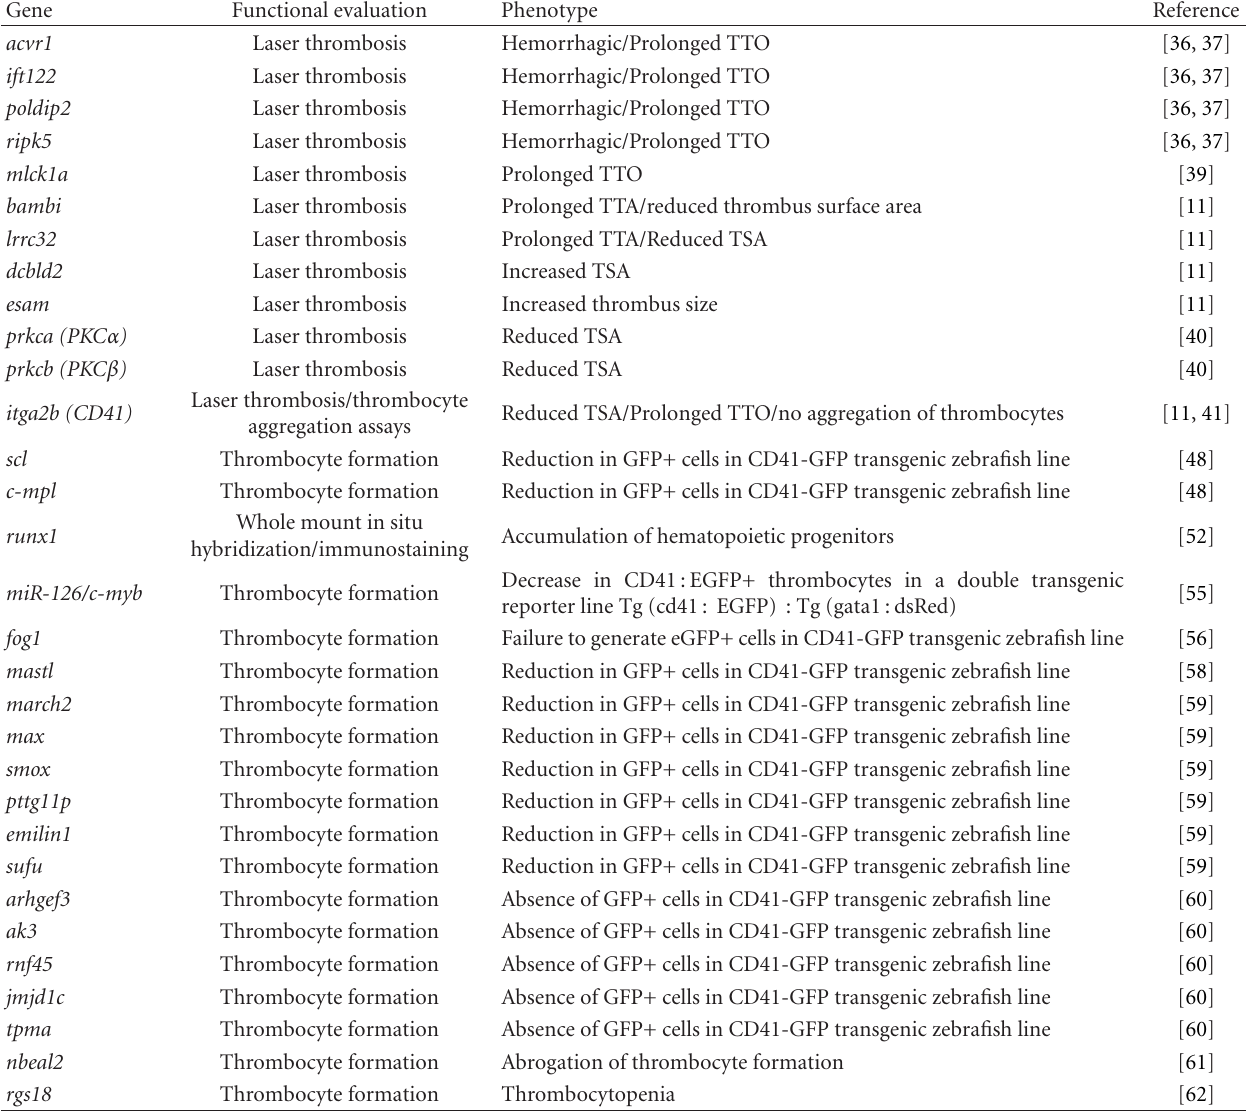
Table 1: Summary of the silencing of genes by knockdown methods a ff ecting thrombocyte